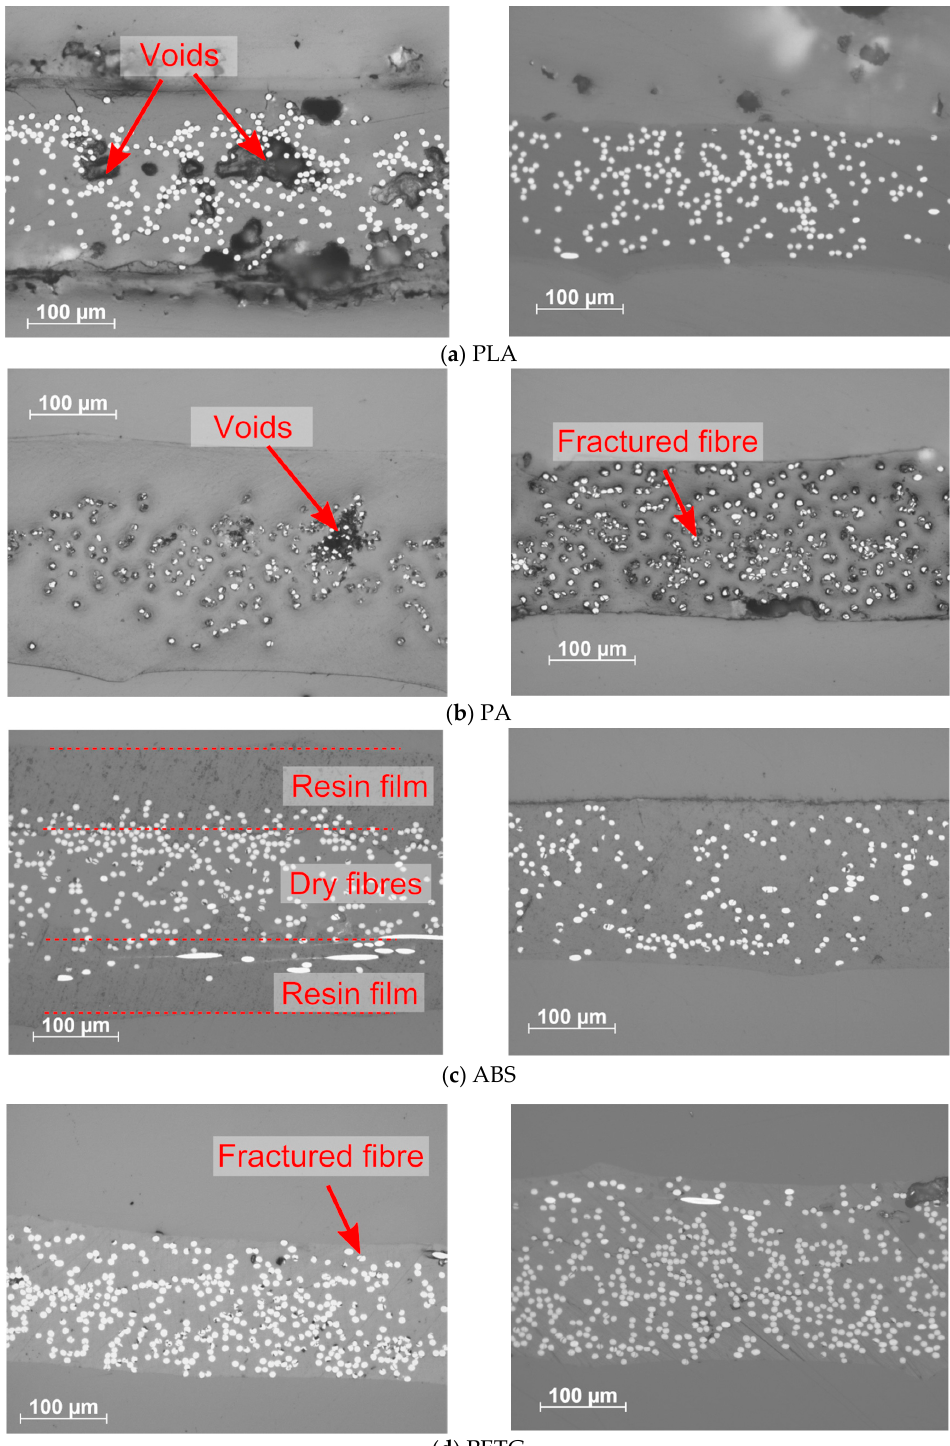
Figure 15. Optical micrographs of different ADFRPs, left low processing temperatures and right high processing temperatures: ( a ) PLA ( b )PA ( c ) ABS ( d ) PETG.